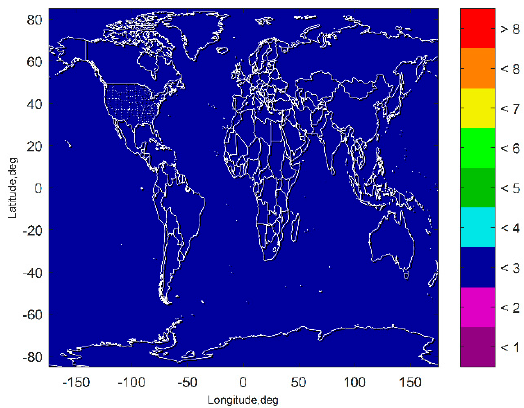
Figure 10. EMT-I of subset-reduced GNSS/INS ARAIM.